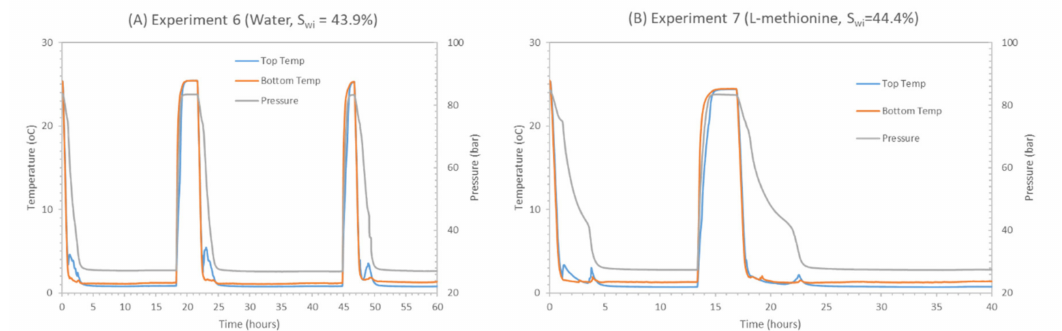
Figure 6. Pressure and temperature profiles for CH 4 hydrate formation experiments for water ( left ) and methionine ( right ) with the same experimental parameters (injection pressure ≈ 85 bar, S wi ≈ 44%, and targeted temperature 1 ◦ C). ( A ) P-T Profile during methane hydrate formation in the presence of Water and S wi = 43.9%; ( B ) P-T Profile during methane hydrate formation in the presence of L-methionine and S wi =